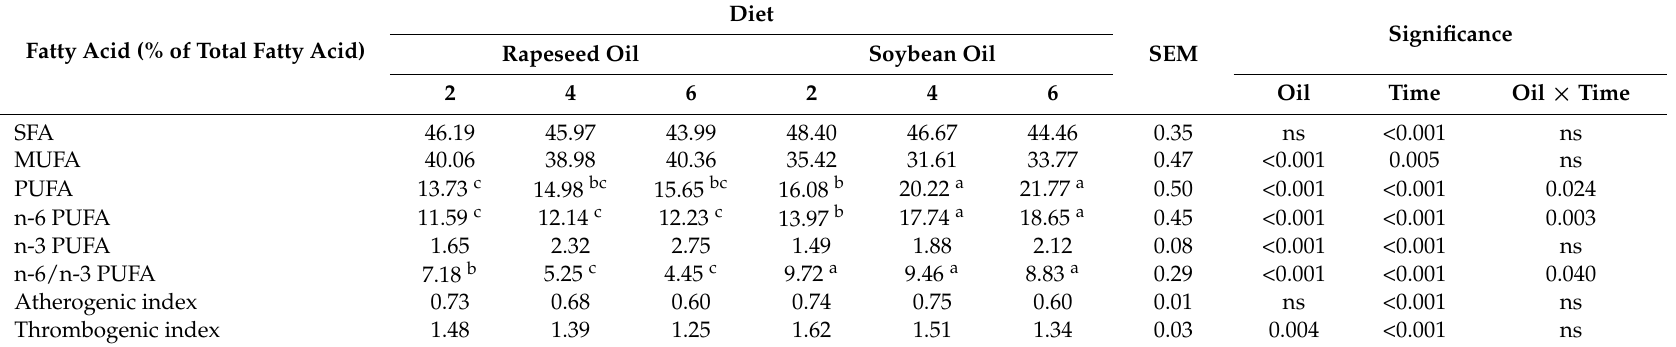
Table 5. Sums and ratios of fatty acids and indexes of